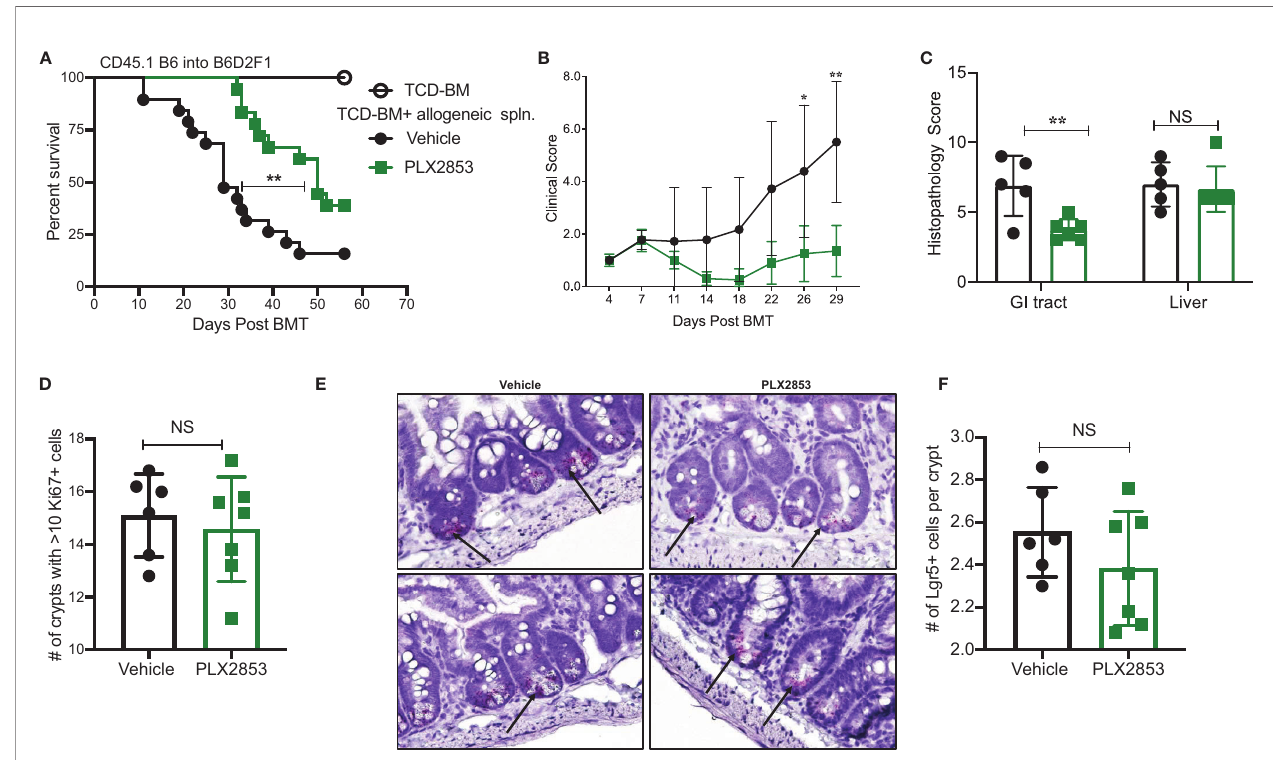
FIGURE 2 | PLX2853 improves survival in mouse model of aGVHD. Lethally irradiated F1 recipients received TCD-BM only (n=10) or TCD-BM + CD45.1 B6 splenocytes. Recipients of allogeneic splenocytes (n=18-19 each) were treated with PLX2853 or vehicle by oral gavage three times weekly starting day +1 post- transplant. (A) Survival curve. Log-rank test. (B) Clinical scores. Mice were sacri fi ced between day 25-28 post-transplant, (n=5 – 6 per group) and (C) Histopathological score of H&E-stained liver and GI tract tissue sections, (D) Ki67 quanti fi cation between Vehicle and PLX2853. (E) Lgr5+ In-situ hybridization. (F) Lgr5+ analysis. Data combined from three independent transplant experiments. *p < 0.05, **p < 0.01. NS, not signi fi